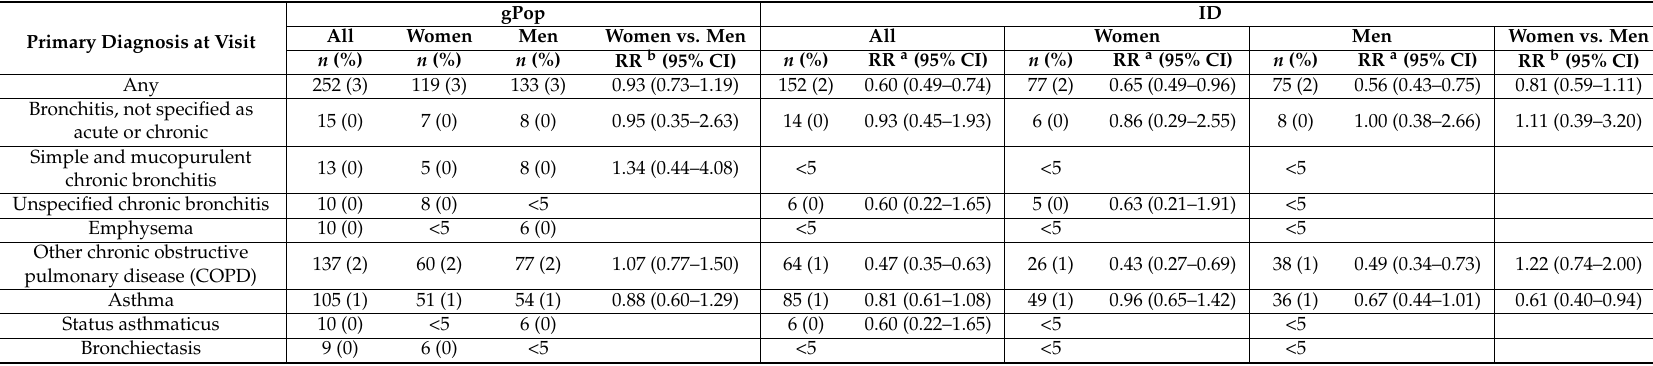
Table 1. The number of people with at least one inpatient or outpatient specialist visit due to different types of chronic respiratory diseases in a cohort of people with intellectual disabilities (ID, n = 7936) and a same-sized referent sample from the general population (gPop), matched by sex and year of